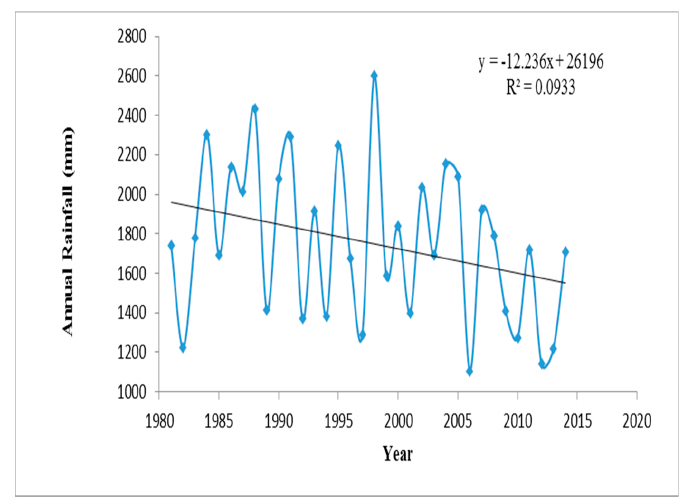
Figure 4. Trend of total annual rainfall (mm) of Bogra station (1981–2015).